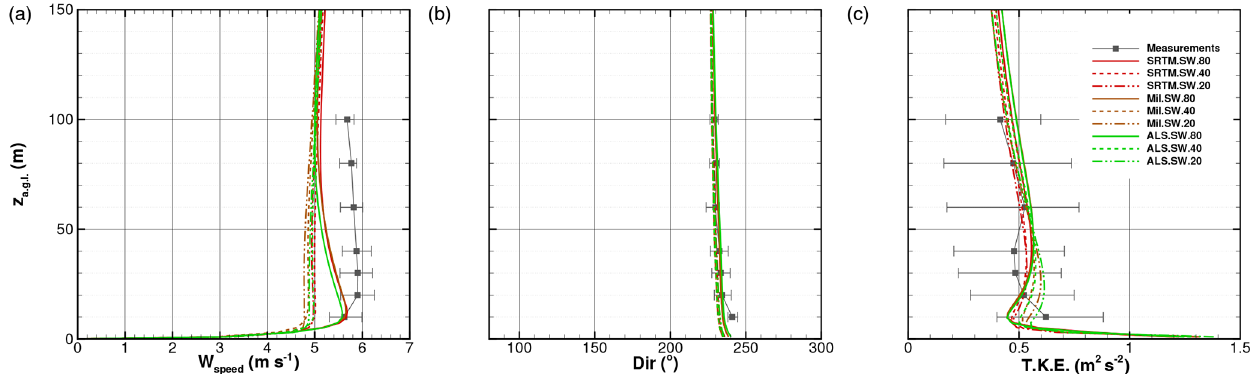
Figure 14. Simulation results and experimental data in tower 20/tse04 for SW winds: (a) wind speed, (b) wind direction, (c) turbulent kinetic energy.